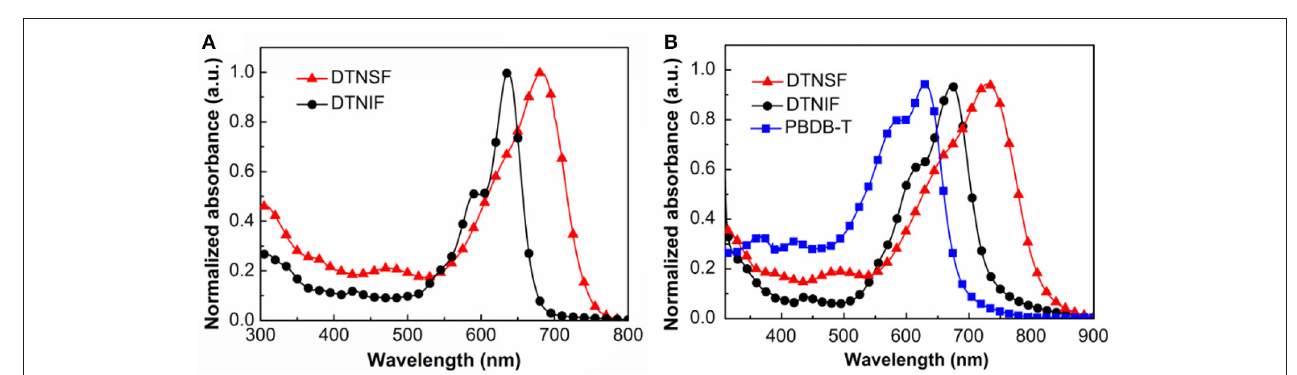
FIGURE 2 | (A) Normalized UV–Vis absorption spectra of DTNIF and DTNSF in CHCl 3 . (B) Normalized UV–Vis absorption spectra of DTNIF, DTNSF, and PBDB-T in thin film.